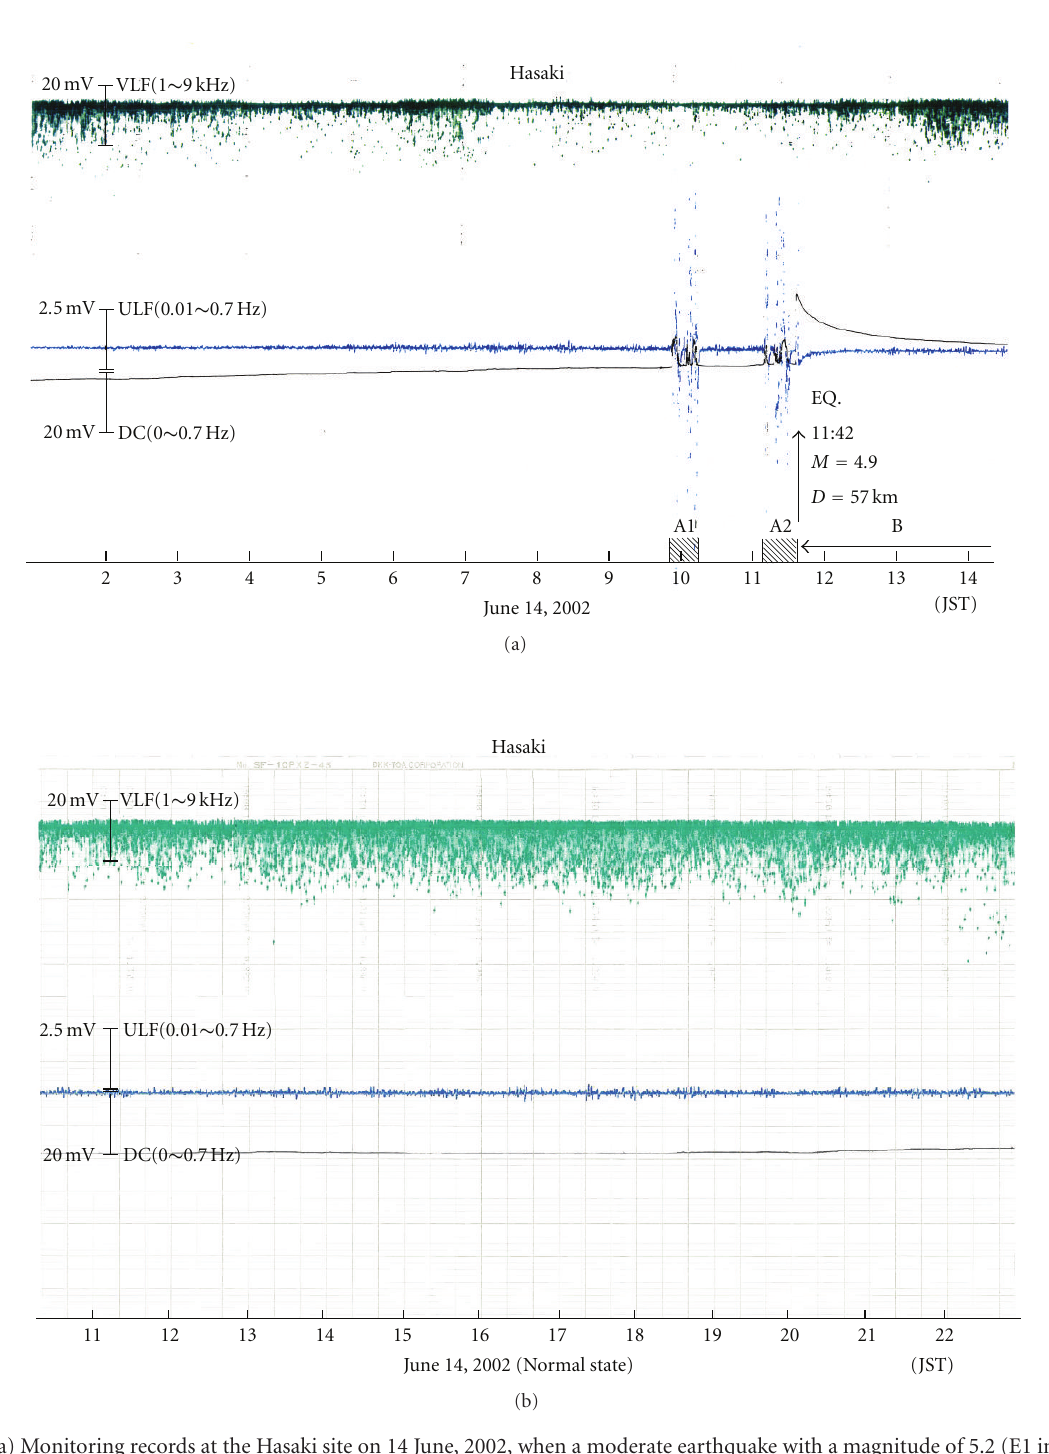
Figure 2: (a) Monitoring records at the Hasaki site on 14 June, 2002, when a moderate earthquake with a magnitude of 5.2 (E1 in Figure 1) with depth 57 km occurred about 100 km west from the borehole observation site. The recorder was a low-speed analog machine recording at 1.5 cm/h. The focal parameters were chosen by the National Research Institute for Earth Science and Disaster Prevention (NIED). Three channels are shown corresponding to VLF/ELF, ULF, and DC bands. In the DC (black) and ULF (blue) bands there appeared two similar anomalies (A1, A2) and second type of variation (B), both of which are clearly di ff erent from the normal state. The fluctuating parts in the DC channel are enlarged in the ULF band. There are no anomalies found in the VLF/ELF. Anomalies A1 and A2 are arged to be immediate-term precursory phenomena to the earthquake, not of urban or natural origin, including meteorological or geomagnetic causes. (b) Monitoring records of the vertical electric field observed at the Hasaki site in a typical normal state on 12 June, 2002. Amplification parameters were chosen in the experimental period of approximately three months so that the background noise level would be less than 1/10 of the full scale in the paper